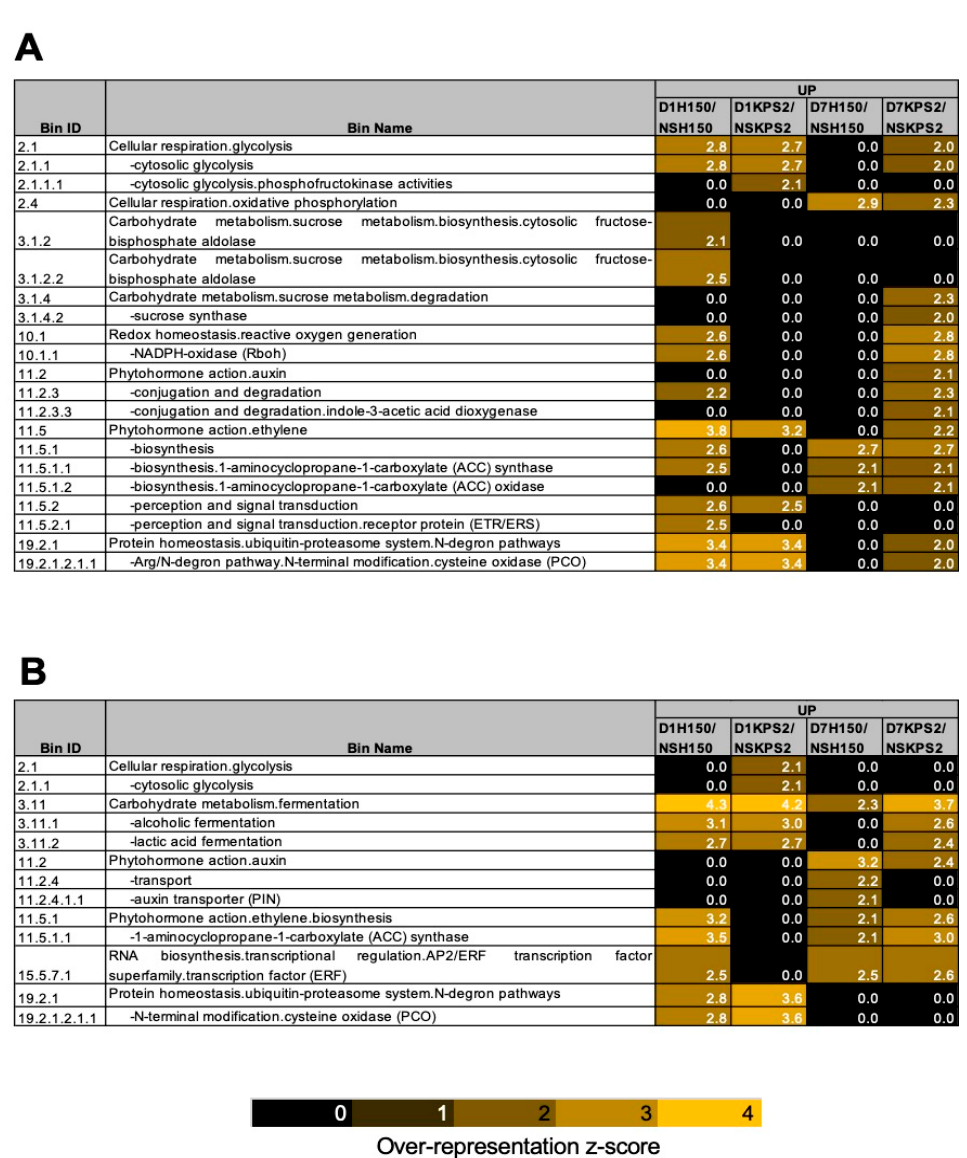
Figure 3. PAGEMAN over-representation analysis of DEGs (for selected functional categories). ( A ) Log2 Fold Change cutoff = 1. ( B ) Log2 Fold Change Cutoff = 2. Data used to generate this figure can be found in Table S5.